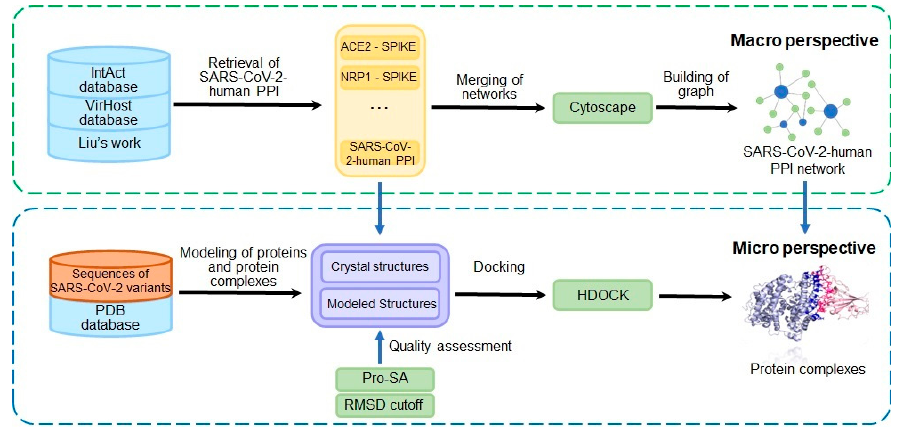
Figure 1. The integration of SARS-CoV-2–human PPI network and virus-host protein structural binding state. The PPI network was merged with experimental PPIs from multiple sources. Binding structures were collected from both experiments and calculations. The 3D view of S protein (Omi- cron BA.2 variant) and ACE2 protein binding as a demonstration was captured from the structure modeled in this research.